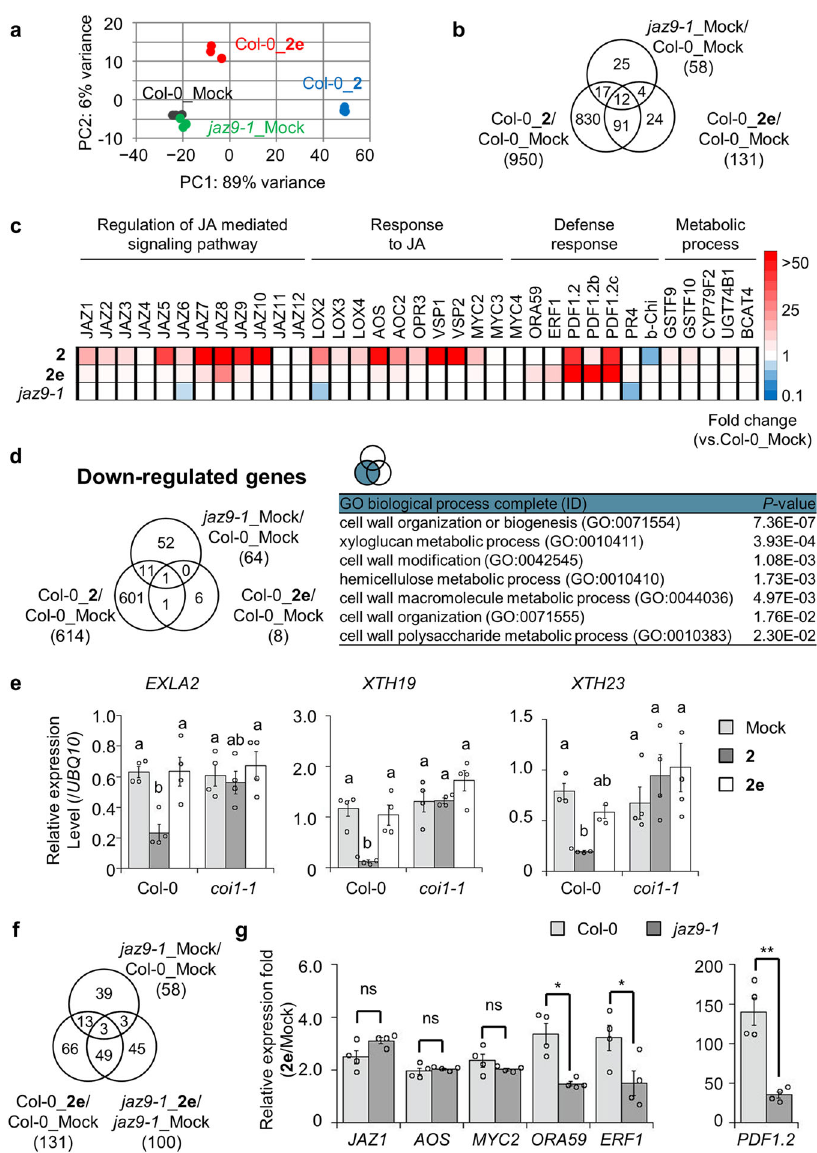
Fig. 4 Gene expression analyses of 2- and 2e-treated Col-0 and jaz9-1 seedlings. a Principal component analysis of upregulated genes in each compound-treated 6-day-old Arabidopsis seedlings by RNAseq analyses (fold change >2.5, FDR < 0.1). Black, blue, red, and green dots showed three independent replicates of each treatment. b Venn diagram (FDR < 0.1) indicates the number of upregulated genes at least 2.5-fold change in response to different treatments. c Heatmap illustrating changes in gene expression of jasmonate response to different treatments (FDR < 0.1). Each GO ID is as follows: Regulation of JA mediated signaling pathway: 2000022, Response to JA: 0009753, Defense response: 0006952, Metabolic process: 0008152. d Venn diagram (FDR < 0.1) indicating the number of downregulated genes at least 2.5-fold change in response to different treatments and GO enrichment analysis. e Gene expression analyses of cell wall organization-related genes by RT-qPCR in Col-0 and coi1-1 seedlings ( n = 4) with or without compound treatment (1 µ M) for 8 h. Similar results were obtained in three independent experiments. Signi fi cant differences were evaluated by one-way ANOVA/ Tukey HSD post hoc test ( p < 0.05). Values are mean ± SE. f Venn diagram (FDR < 0.1) indicating the number of upregulated genes at least 2.5-fold change in response to different treatments in Col-0 and jaz9-1 . g RT-qPCR analyses in Col-0 and jaz9-1 seedling ( n = 4) with or without compound treatment obtained in three independent experiments. Signi fi cant differences were evaluated by Student ’ s t-test (** p < 0.01, * p < 0.05; ns, not signi fi cant). Values are mean ±